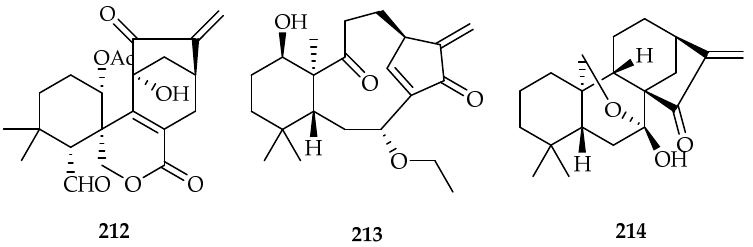
Figure 84. Structures of isoresbin A 212 [131] and croyanhuins A 213 and C 214 [132]. Pharicin D 215 , pharicin M 216 , pharicin Q 217 , and pharicin R 218 (Figure 85) were